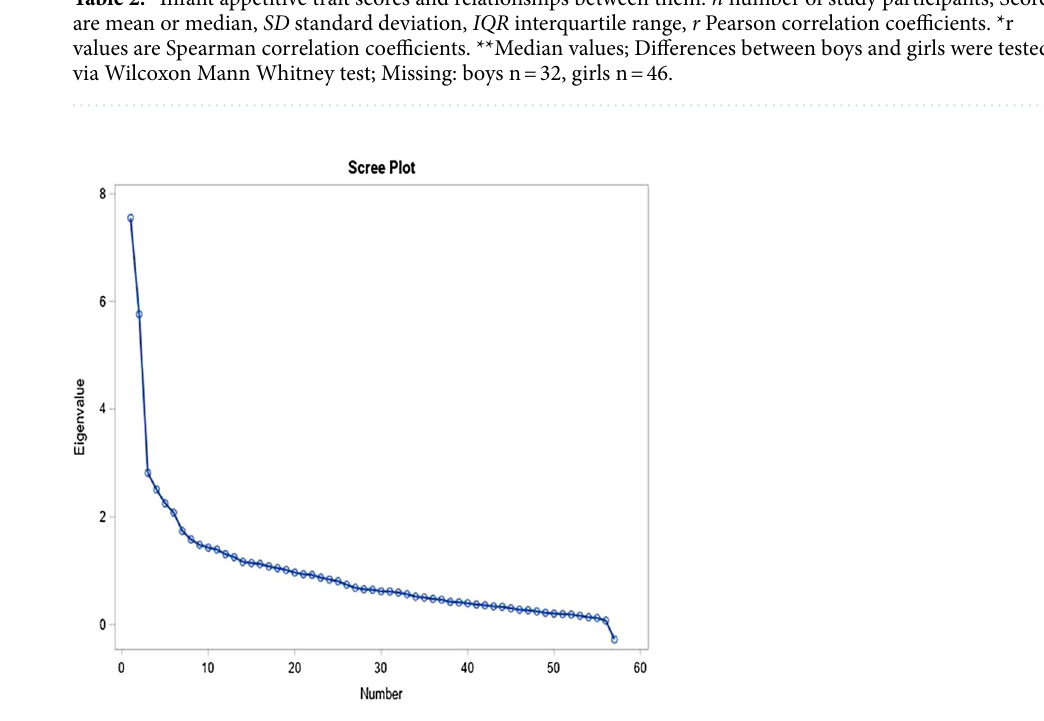
Figure 1. Scree plot for principal component analysis of maternal